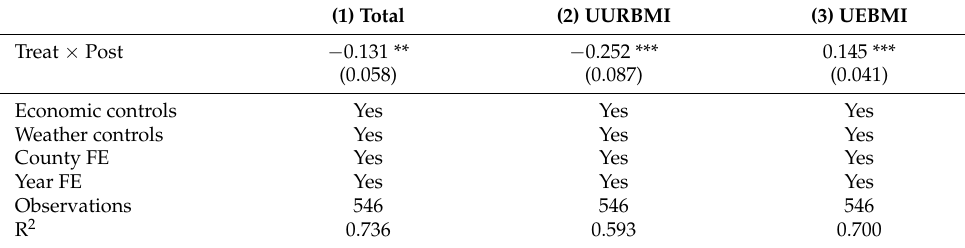
Table 6. Robustness checks: exclude other samples in Yueyang, Changde and Yiyang.